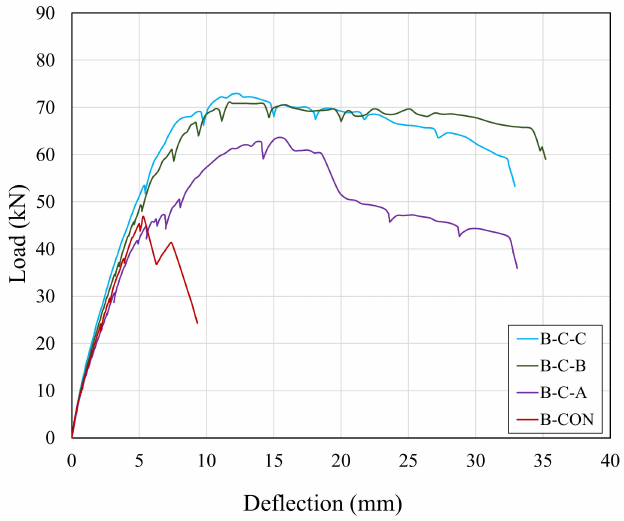
Figure 14. Load-deflection curves of control and cotton FRRP composite strengthened